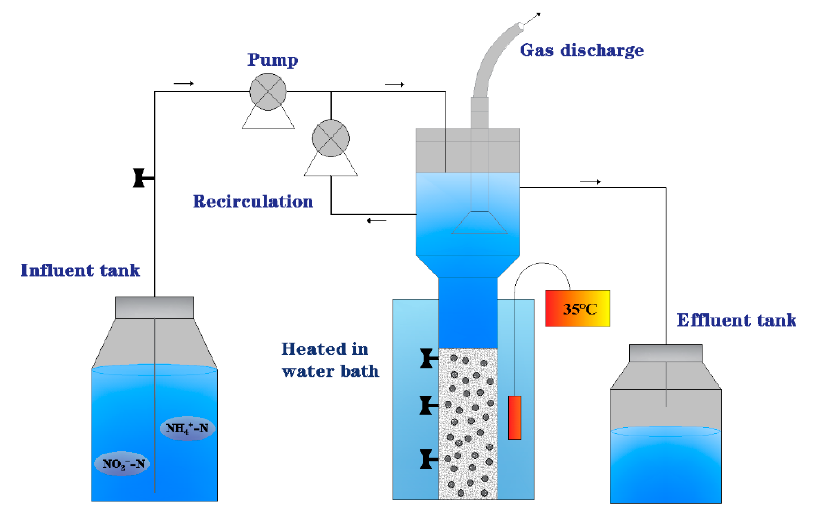
Figure 1. Schematic diagram of the expanded granular sludge beds (EGSB) used in the